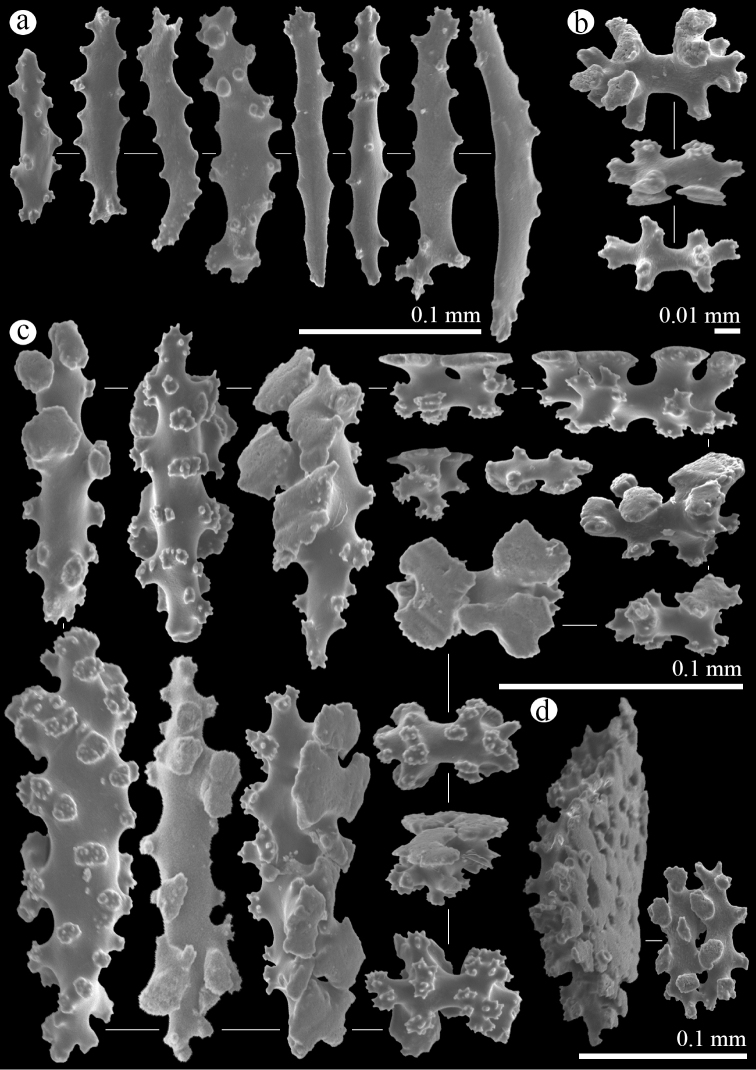
Hanahanagasa, holotype, OKA170711-15: a anthocodial rods b 6-radiates of calyx c table-radiates of calyx d pieces of fused table-radiates of stolon.